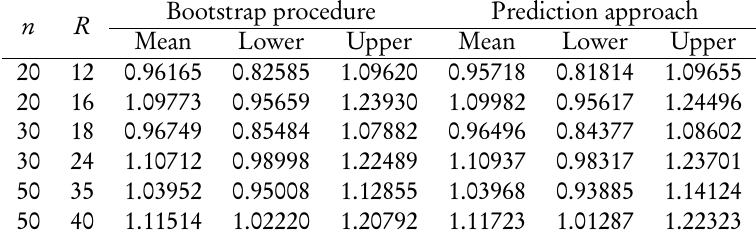
Average Bootstrap and predictive estimates and 95% confidence intervals of Rth order statistics for fixed values of α = 2 and β = 2